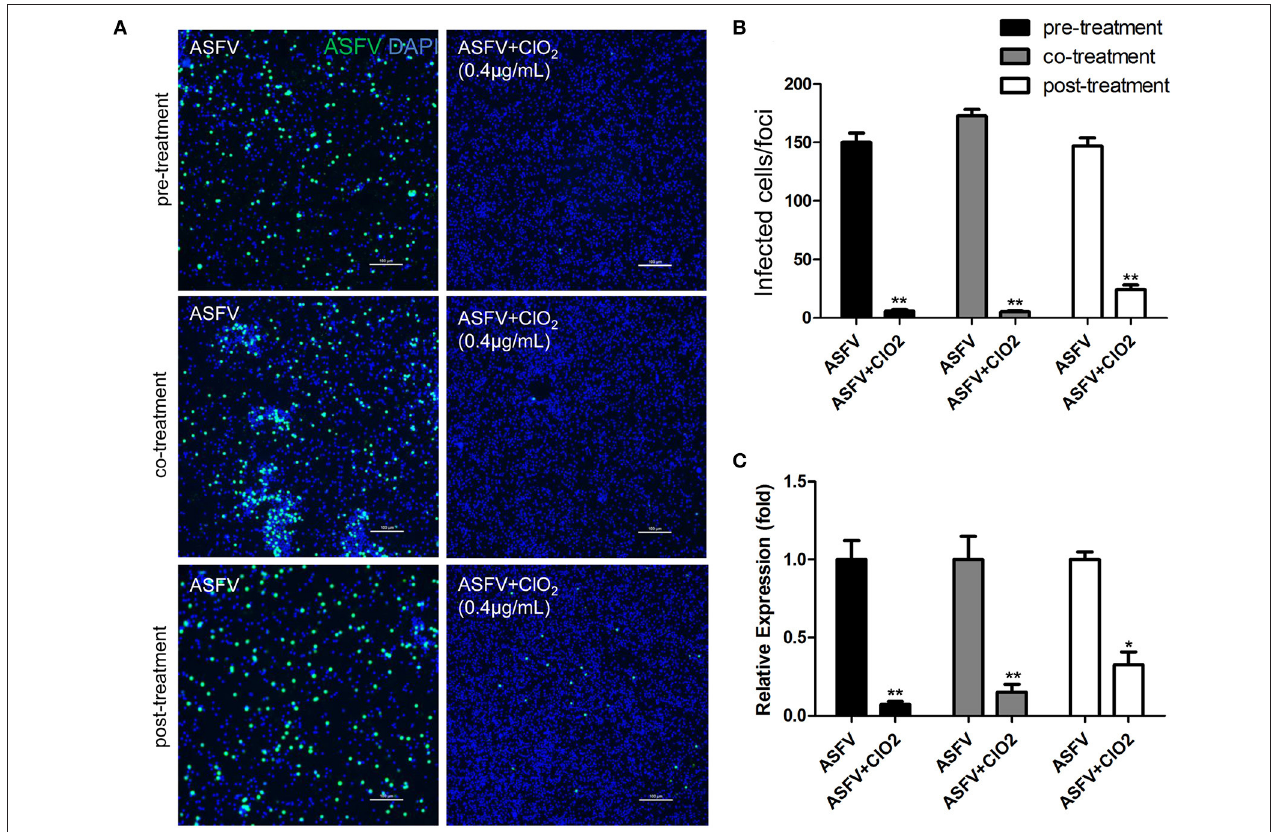
FIGURE 3 | ClO 2 shows effective antiviral activity against ASFV regardless of pre-treatment, co-treatment or post-treatment. (A,C) ClO 2 treatment was performed either before (pre-treatment), simultaneously with (co-treatment), or after ASFV infection (post-treatment) in PAMs. After cultured for 24h, cells were fixed for the determination of the expression of virus p30 protein using fluorescence microscope (A) or harvested for the evaluation of the mRNA expression of the viral p72 by qRT-PCR (C) . Bar, 100 µ m. (B) Average number of infected cells per foci. Data are representative of the results of three independent experiments (means ± SE). Significant differences compared with control group are denoted by * P < 0.05, ** P < 0.01, and *** P <